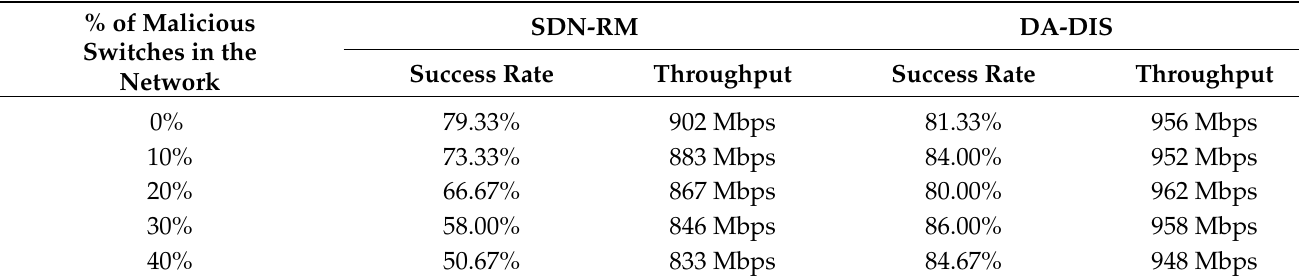
Table 2. Results overview of Case 5.